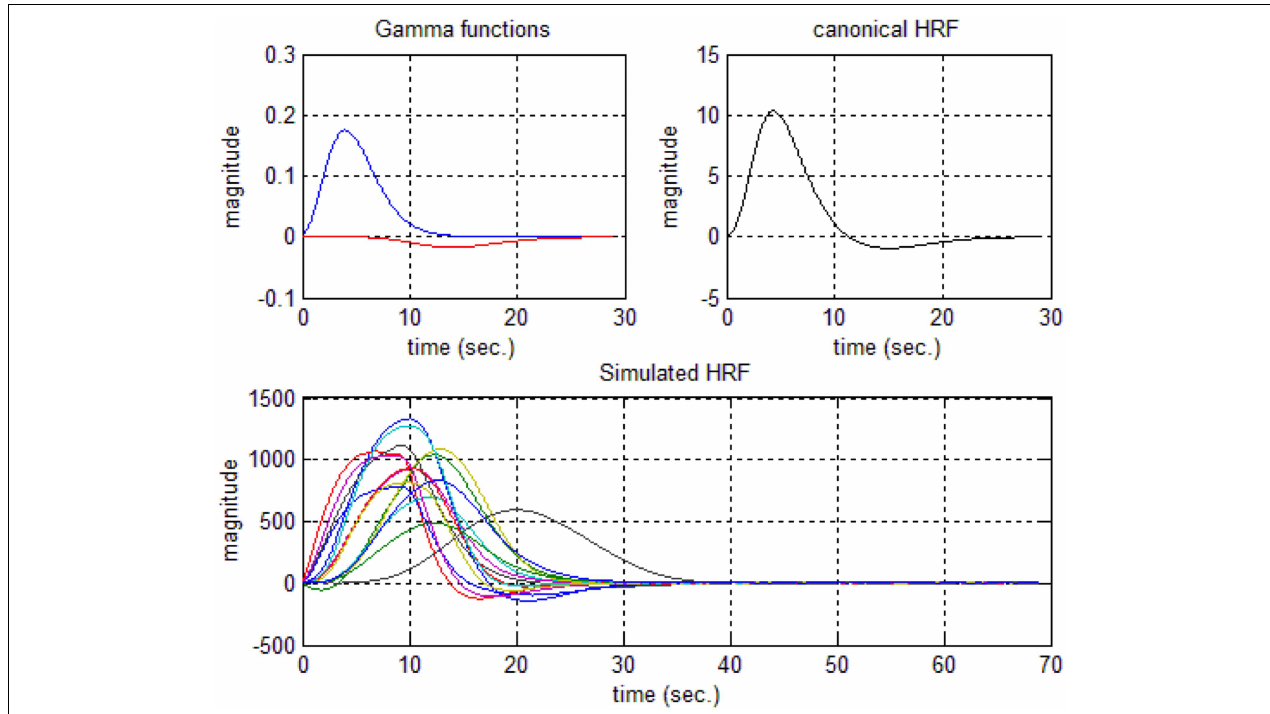
FIGURE 3 | Hemodynamic response function generations: two Gamma functions for generation of cHRF (top left), the standard cHRF (top right) and different simulated HRF (bottom).